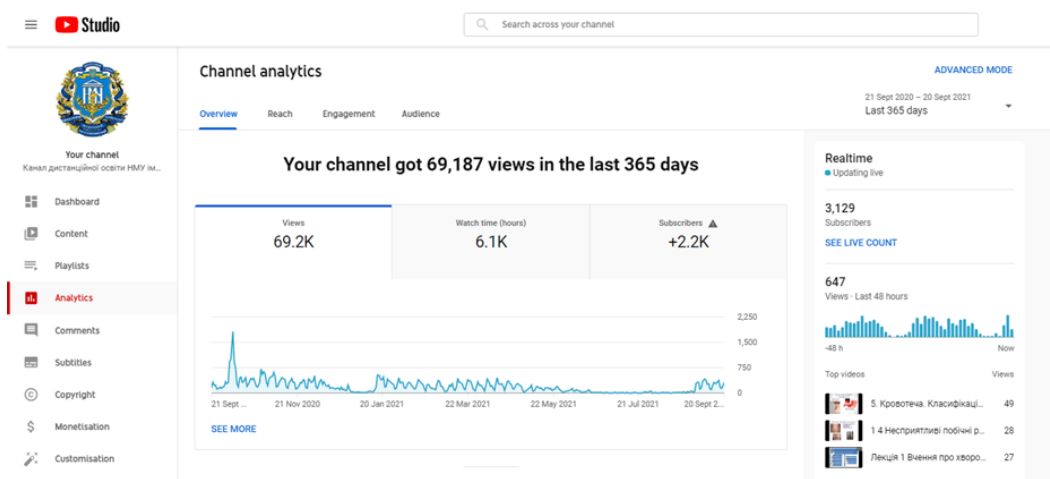
Figure 4: Analytics of views of the YouTube distance learning channel of Bogomolets